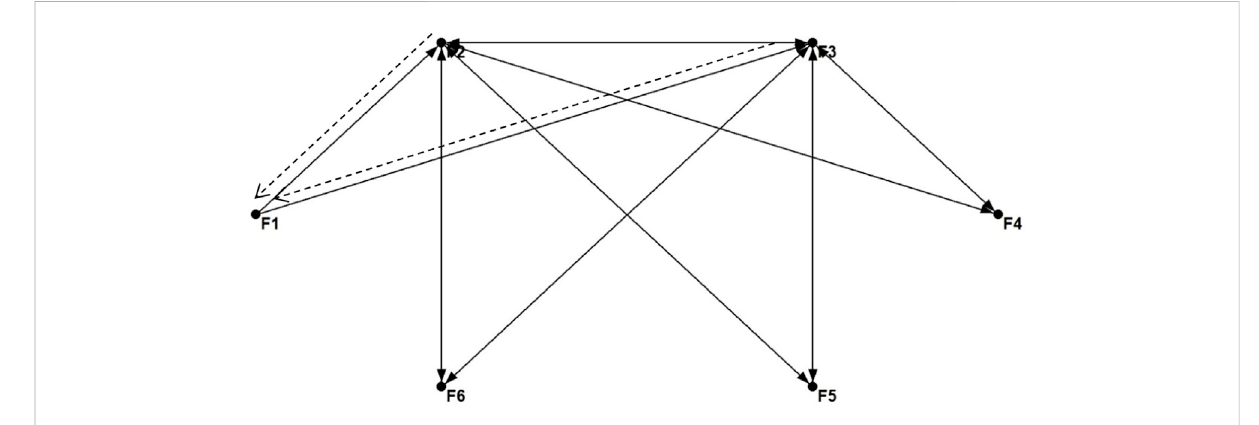
FCM for the industry sector, Source: own